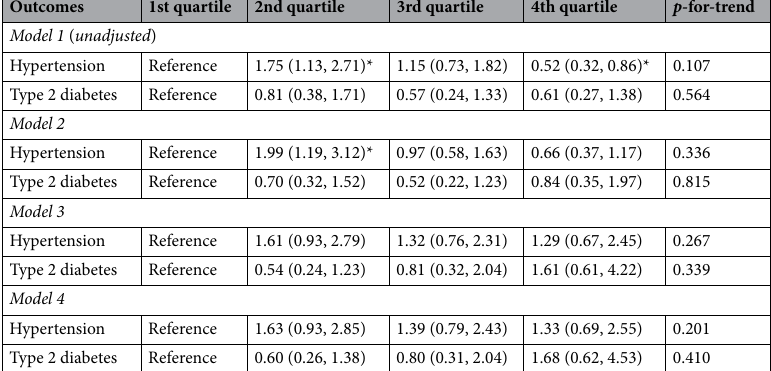
Table 4. Logistic regression models of the association between egg consumption and hypertension (yes or no) and type 2 diabetes (yes or no). Values indicate the odds ratio (95% confidence interval) obtained through logistic regression models. Hypertension was defined as systolic blood pressure ≥ 140 and/or diastolic blood pressure ≥ 90 mmHg or using antihypertensive drugs. Type 2 diabetes was defined as HbA1c ≥ 6.5% or using antidiabetic drugs. Model 1: unadjusted. Model 2: adjusted for age (continuous, years), sex (male, female) and education level (primary or secondary studies, university studies). Model 3: Model 2 adjusted for body mass index (continuous, Kg/m 2 ), total energy intake (continuous, kcal/day) and adherence to the Mediterranean Diet (continuous, MEDAS score). Model 4: Model 3 adjusted for smoking status (nonsmoker or former smoker, current smoker), alcohol intake (nondrinker, current alcohol drinker) and moderate-to-vigorous physical activity (continuous, minutes/week). * p <